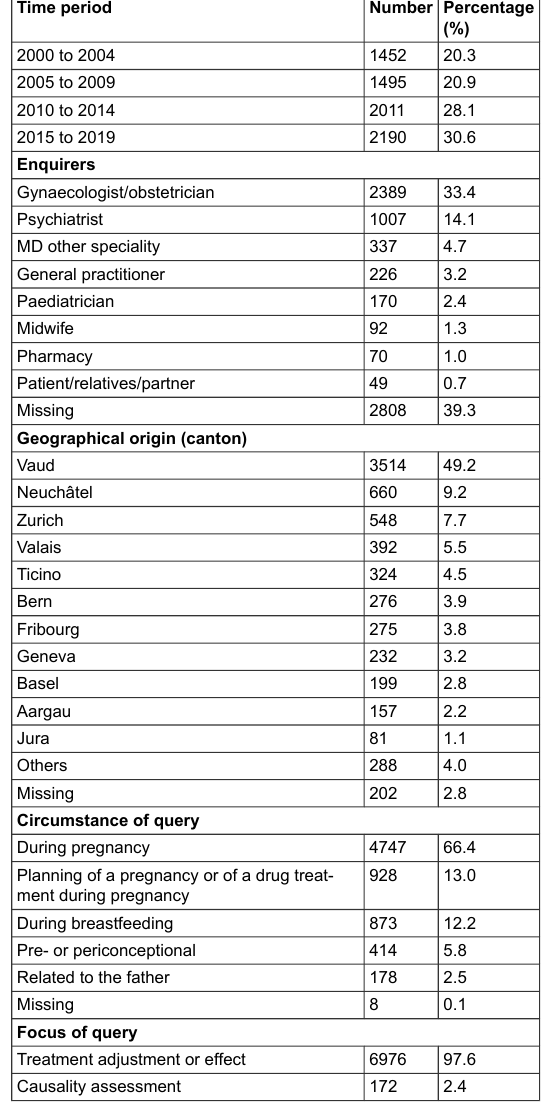
Table 1: Characterisation of the queries addressed to the STIS between 2000 and 2019 (n =